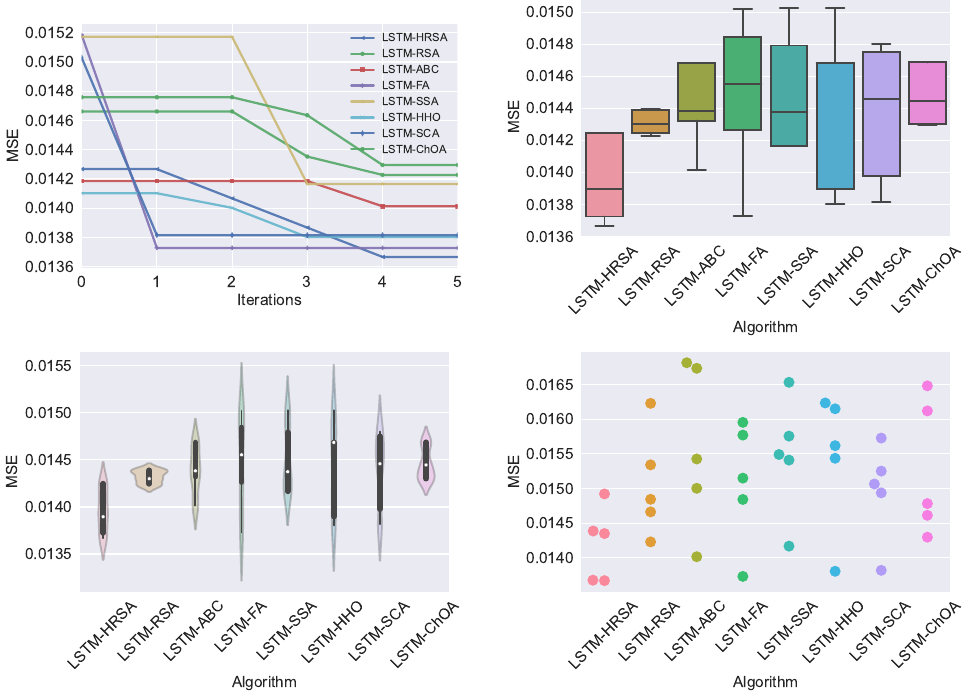
Figure 4. Visual LSTM simulations for each of the 8 optimization methods with respect to the convergence, box plot, violin diagrams, and swarm diversity diagrams of the fitness function